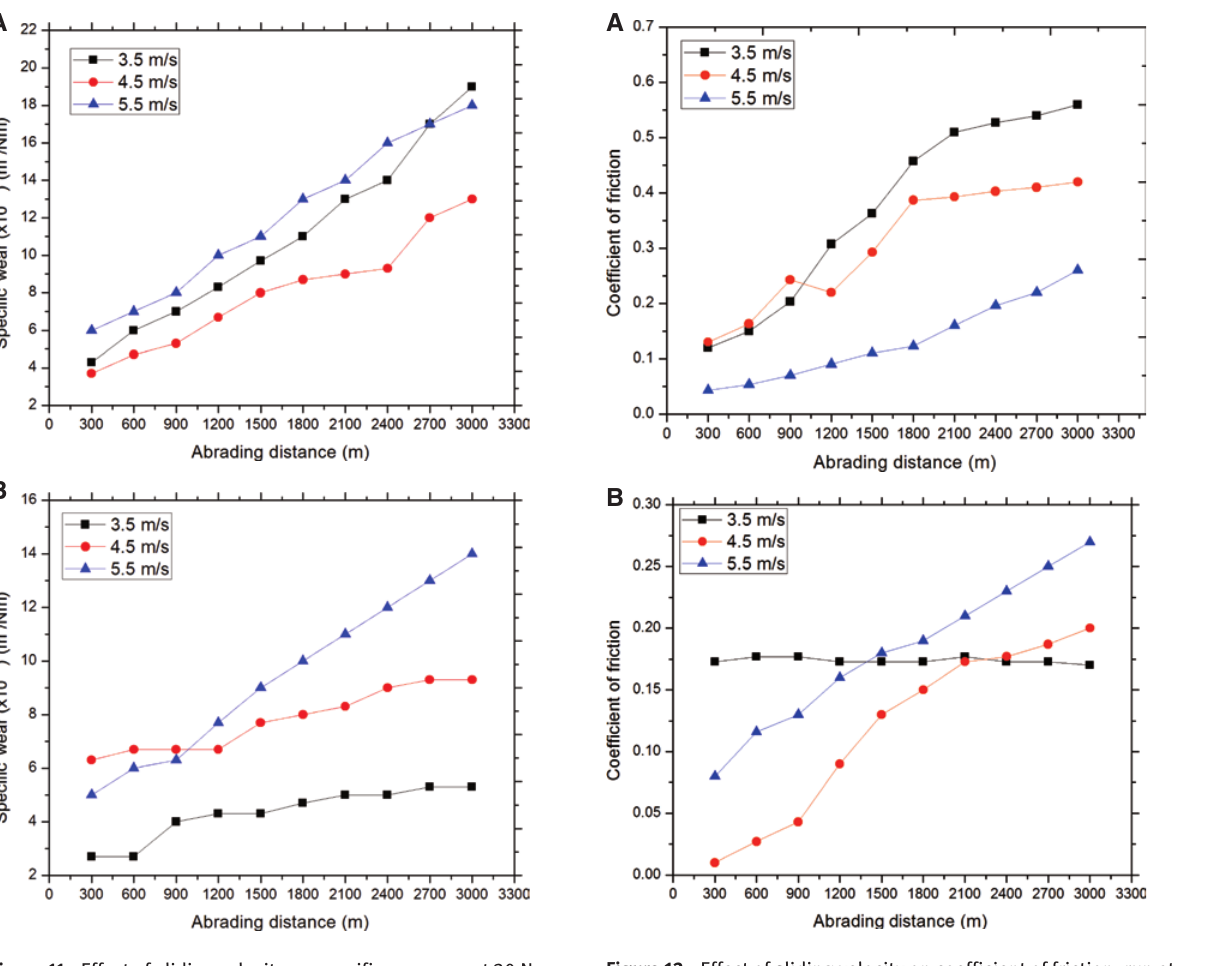
Figure 11 Effect of sliding velocity on specific wear, run at 30 N load: untreated composites (A) and alkali-treated composites (B).